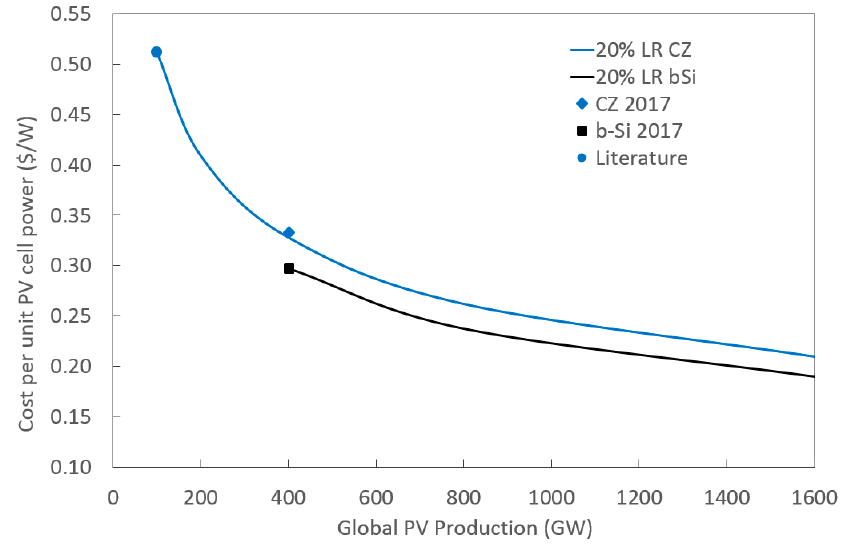
Figure 5. The cost per unit of solar photovoltaic cell power ($/W) as a function of cumulative global PV production in GW.